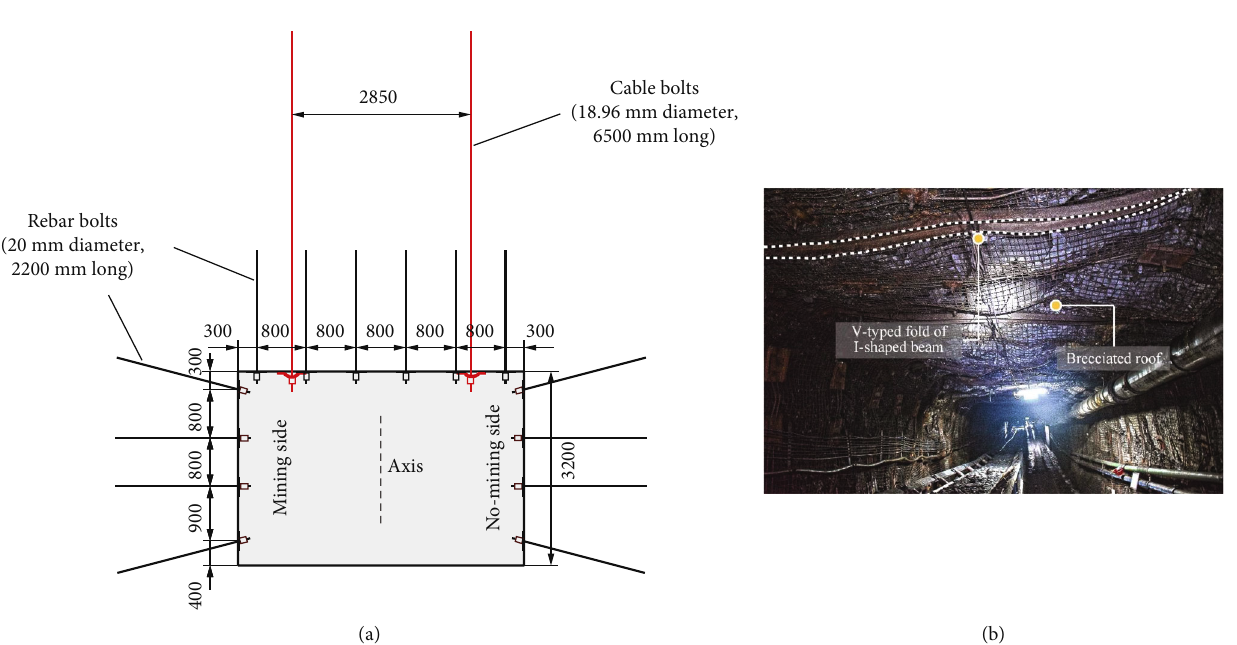
Figure 2: (a) Original support scheme. (b) Damage characteristics of the headentry of 14 -1 106.